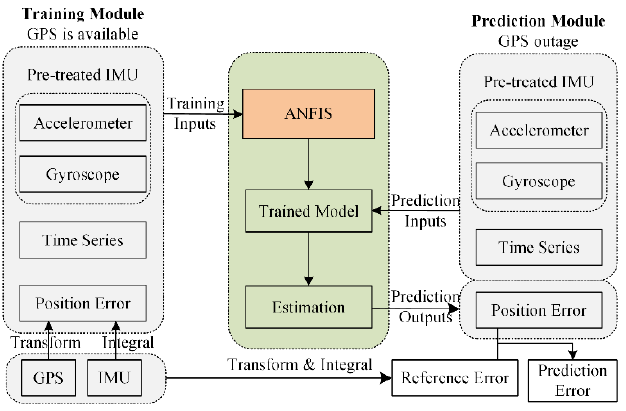
Figure 2. Structure of the accumulative error estimation of INS based on an ANFIS.